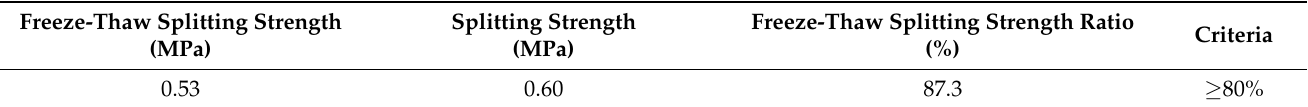
Table 6. Results of the freeze–thaw split test.